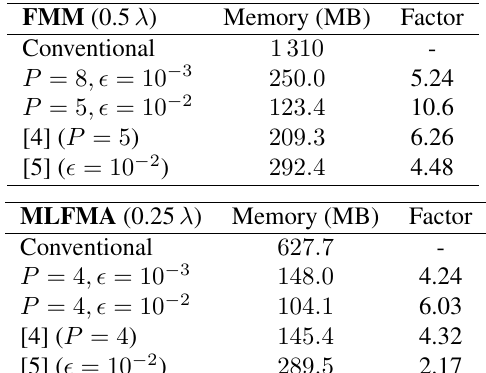
Table 3: Memory for the aggregation matrices with the pro- posed technique using FMM (box size 0.5 λ ) and MLFMA (box size 0.25 λ ). Example: ship surface with 126 962 un- knowns.